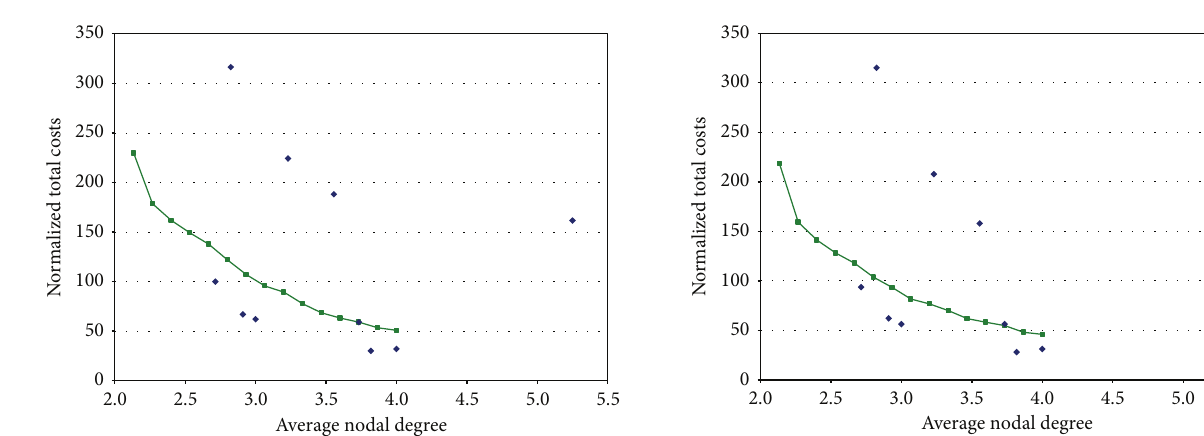
Figure 19: Normalized p -cycle restorable JCA total capacity costs.